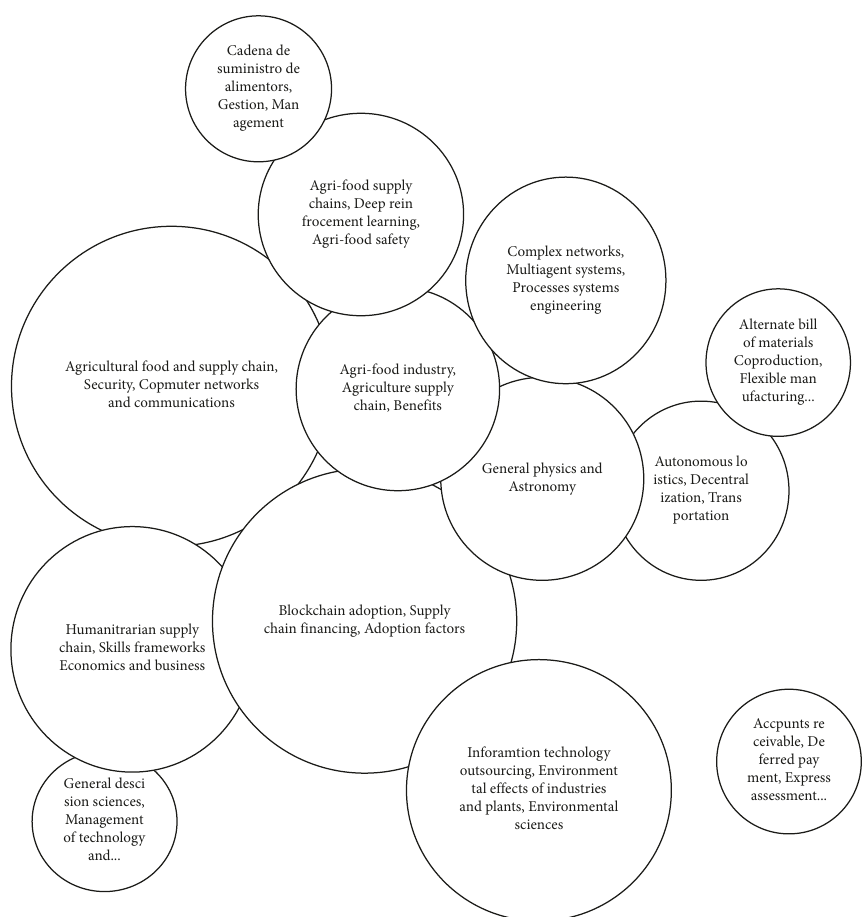
Figure 4: Overview of research on blockchain; supply chain complexity. Source: Open Knowledge Maps (2022). Overview of research on blockchain; supply chain complexity. Retrieved from https://openknowledgemaps.org/map/d8a0604af922b2eb1444eb6d5d153a75 (2 Mar